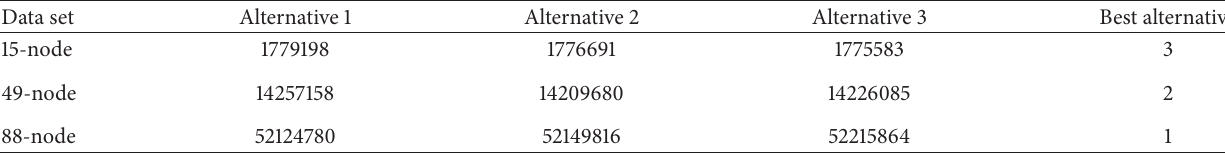
Table 4: Value of objective function corresponding to different